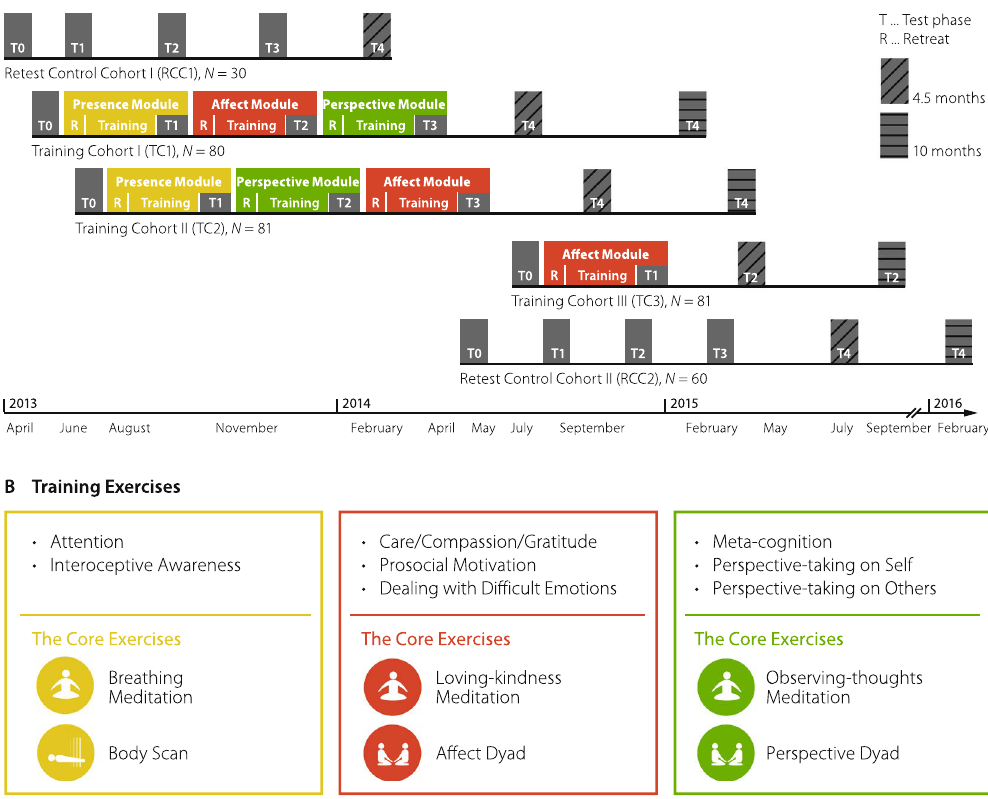
Figure 2. Design and training exercises of the ReSource study. Panel (A) Design and timeline of the longitudinal study. Training and testing took place from April 2013 until February 2016. The timelines for retest control cohorts (RCC1 and RCC2) and training cohorts (TC1, TC2, TC3) are represented one below the other. Training modules in the training cohorts are depicted by coloured areas (yellow for the Presence Module; red for the Affect Module, and green for the Perspective Module); data collection phases are depicted by grey areas (T0- T4). Specifically, TC1 and TC2 completed all three training modules and differed only in the order of the Affect and Perspective Module. TC3 only completed the Affect Module. R in coloured boxes indicates the retreats that took place in the beginning of each module. RCC1 and RCC2 were split for logistical reasons into two smaller cohorts but were jointly analysed. Both retest control cohorts completed all measurements but did not receive any training. Panel (B) Illustration of the trained skills and the core exercises of the three modules (left to right): Presence (yellow), Affect (red), Perspective (green). Source: Figure courtesy of 46